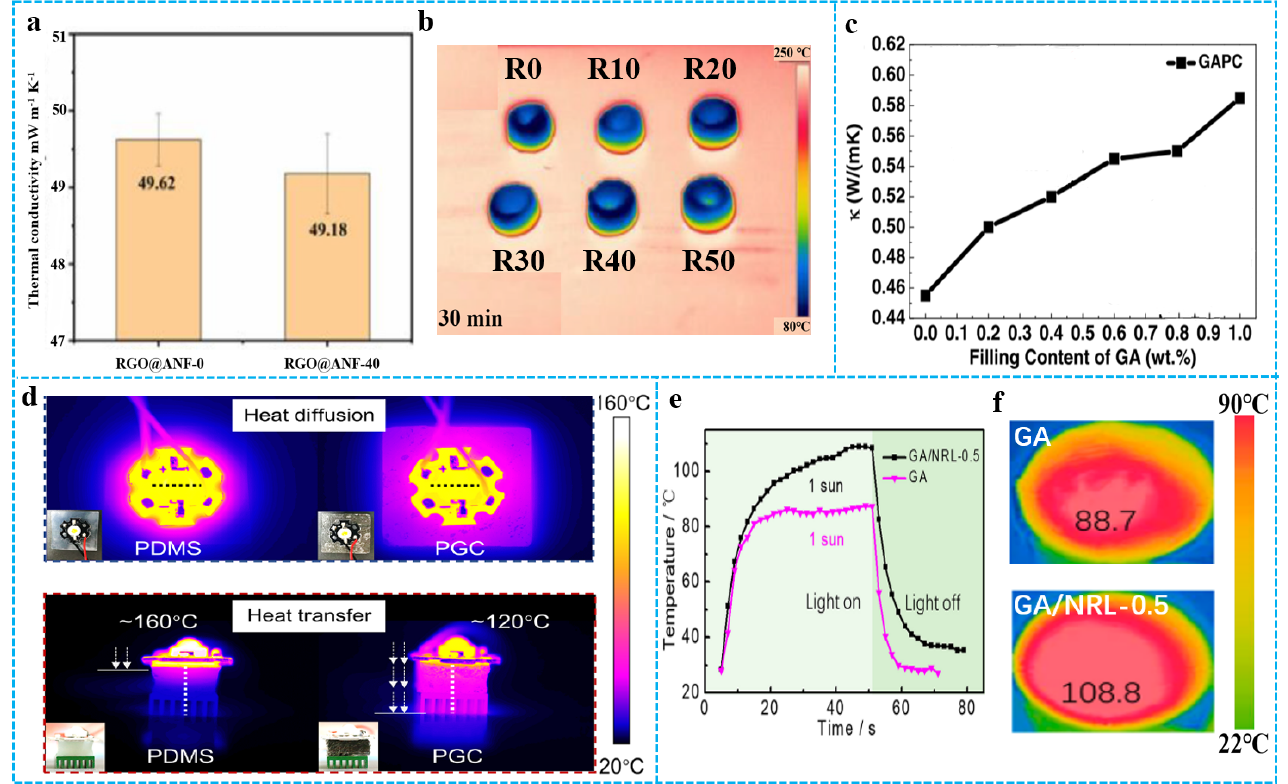
Figure 14. ( a ) Thermal conductivity of RGO@ANF-0 and RGO@ANF-40. ( b ) Thermal infrared images of all aerogels with the temperature of the warm table at 250 ◦ C, R0 to R50 represent RGO@ANF-0 to RGO@ANF-50 respectively. Reproduced with permission from [123]. ( c ) The thermal conductivities of GAPC with different GA contents. Reproduced with permission from [124]. ( d ) Infrared images of an LED lamp with PDMS and a PGC for heat dissipation and infrared images of a LED lamp with PDMS and a PGC for heat transfer. Reproduced with permission from [126]. ( e ) Temperature changing curves of “light on” and “light off” under 1 sun. ( f ) Solar-thermal behavior of GA/ NRL-0.5 and GA under 1 sun. Reproduced with permission from [23].